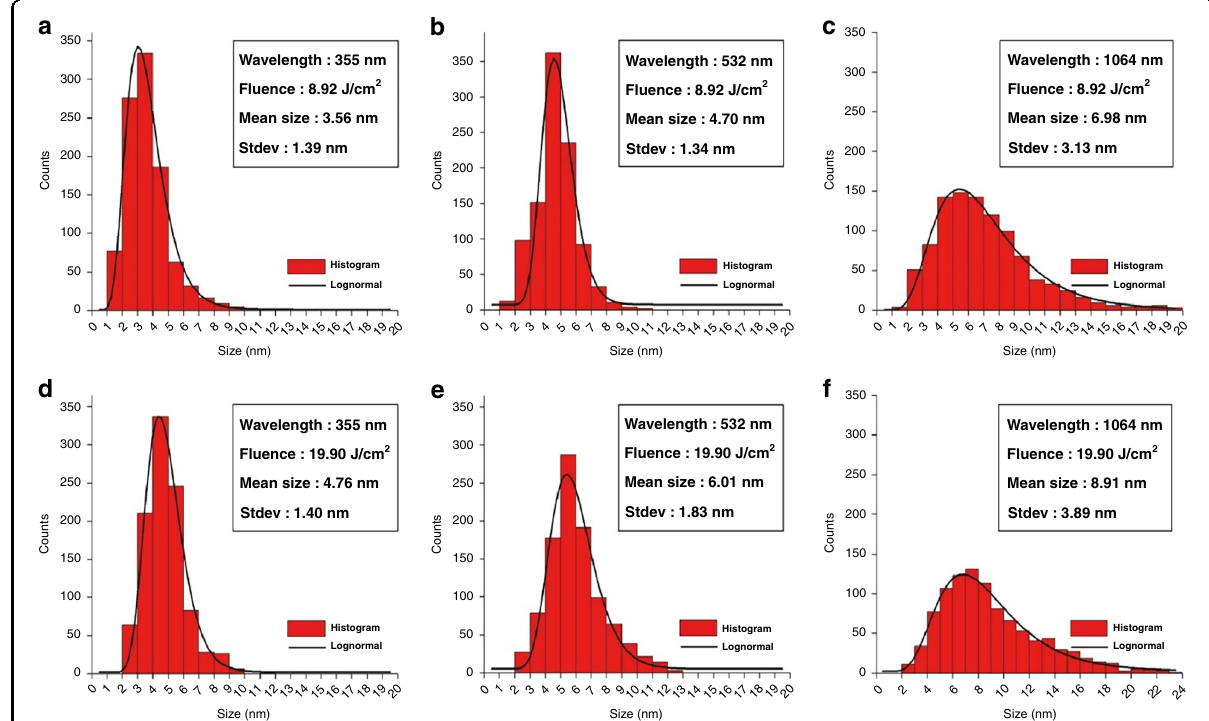
Fig. 3 Average particle size distribution of Pd-NPs synthesized via the PLA of a Pd-foil in water at various laser wavelengths and fl uences. a – c At fi xed 8.92 J/cm 2 fl uence with various wavelengths, 355, 532, and 1064 nm, respectively, d – f at fi xed 19.90 J/cm 2 fl uence with various wavelengths, 355, 532, and 1064 nm, respectively 28 . Copyright (2021)